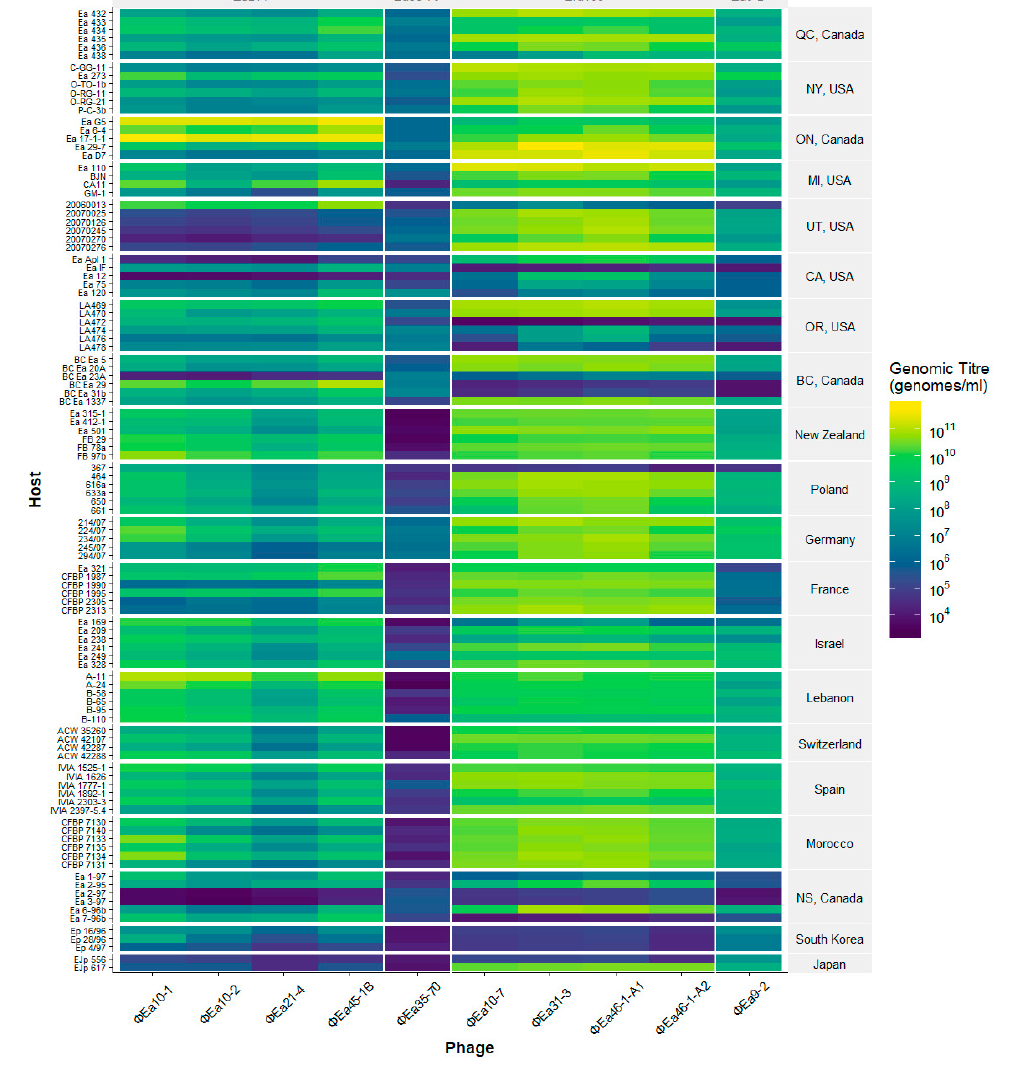
Figure 3. Heat map of the final genomic titre of each phage produced after growth on all hosts. The growth of the phage is indicated by colour, where yellow is maximal total final genomic titre (genomes / mL) and blue shows no growth beyond starting genomic titre of 10 4 genomes / mL after 8 hr incubation. The hosts are indicated on the left y -axis and are separated by their location of isolation on the right y -axis. The phages are indicated along the x -axis and grouped by species at the top. The amount of amylovoran produced by the host is known to affect phage preference [34], and so the relative amount of amylovoran produced by each host (Table 1) was plotted against the final phage genomic titre achieved (Figure 4). The Erwinia virus Ea214 phages achieve their highest genomic titres on low amylovoran producers and show a general decrease in titre as amylovoran increases. These phages also replicate poorest on mostly lower amylovoran hosts from the west but can still achieve higher genomic titres on higher amylovoran producers. The other Myoviridae phage ɸ Ea35-70 does not appear to share any discernable similarity to the Erwinia virus Ea214 phages, with no apparent effect from amylovoran. The Podoviridae species, Erwinia virus Era103 , and Erwinia virus Ea9-2 , show a steep increase in final genomic titre as amylovoran increases in isolates from western North America. Isolates from other regions have a much smaller effect from amylovoran.